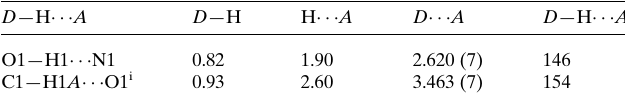
Table 1 Hydrogen-bond geometry (A˚ , (cid:3) ).